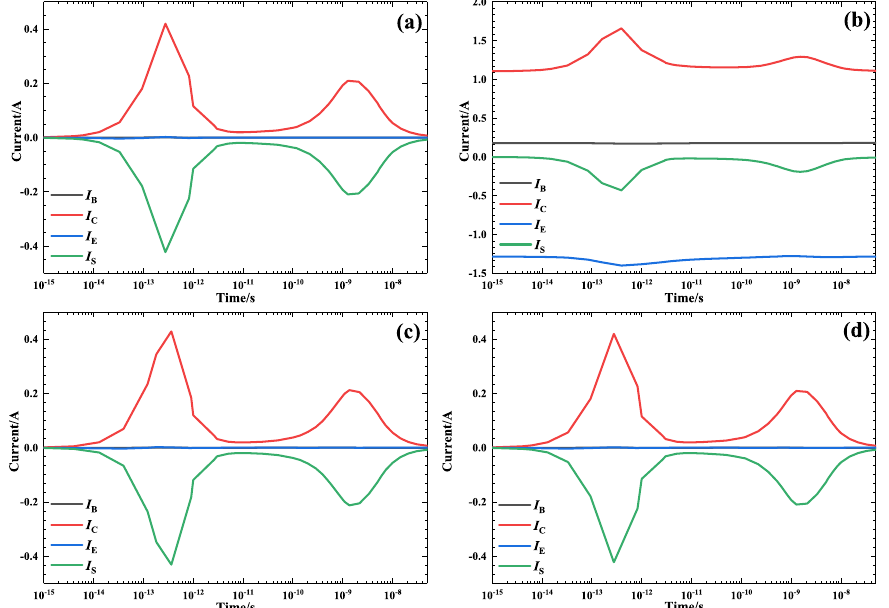
Figure A2. Change in current with time when heavy ions vertically irradiate the collector of the SiGe HBT under the substrate inverse bias ( a ), positive bias ( b ), off bias ( c ) and collector positive bias ( d )